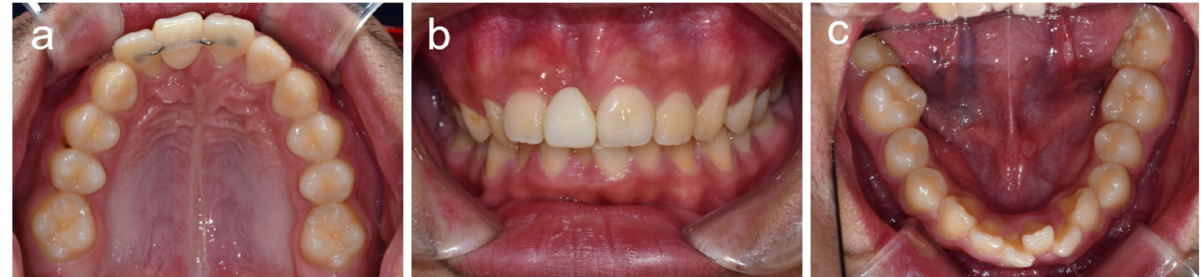
Figure 5. Clinical photos of patient 3. ( a – c ) Clinical photos at age 17 years 4 months.